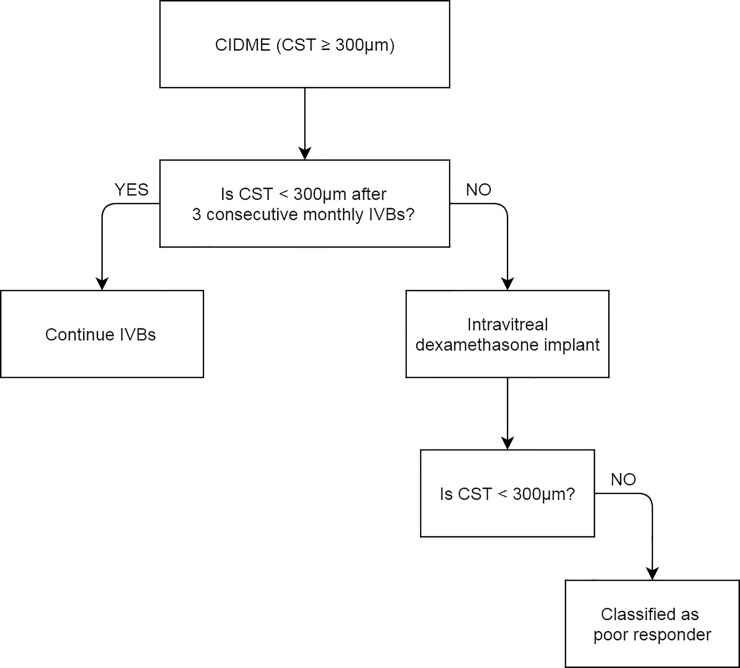
Flowchart showing treatment decision tree for CIDME.Naïve CIDME patients were treated with 3 consecutive IVBs and if CST after treatments was reduced to < 300μm then IVB was continued. If their CST ≥ 300μm after 3 consecutive IVBs, intravitreal dexamethasone implant was inserted. If these patients still remained to show CST > 300μm, then they were classified as poor responders. CIDME = Center involving diabetic macular edema; CST = Central subfield thickness; IVB = intravitreal bevacizumab.